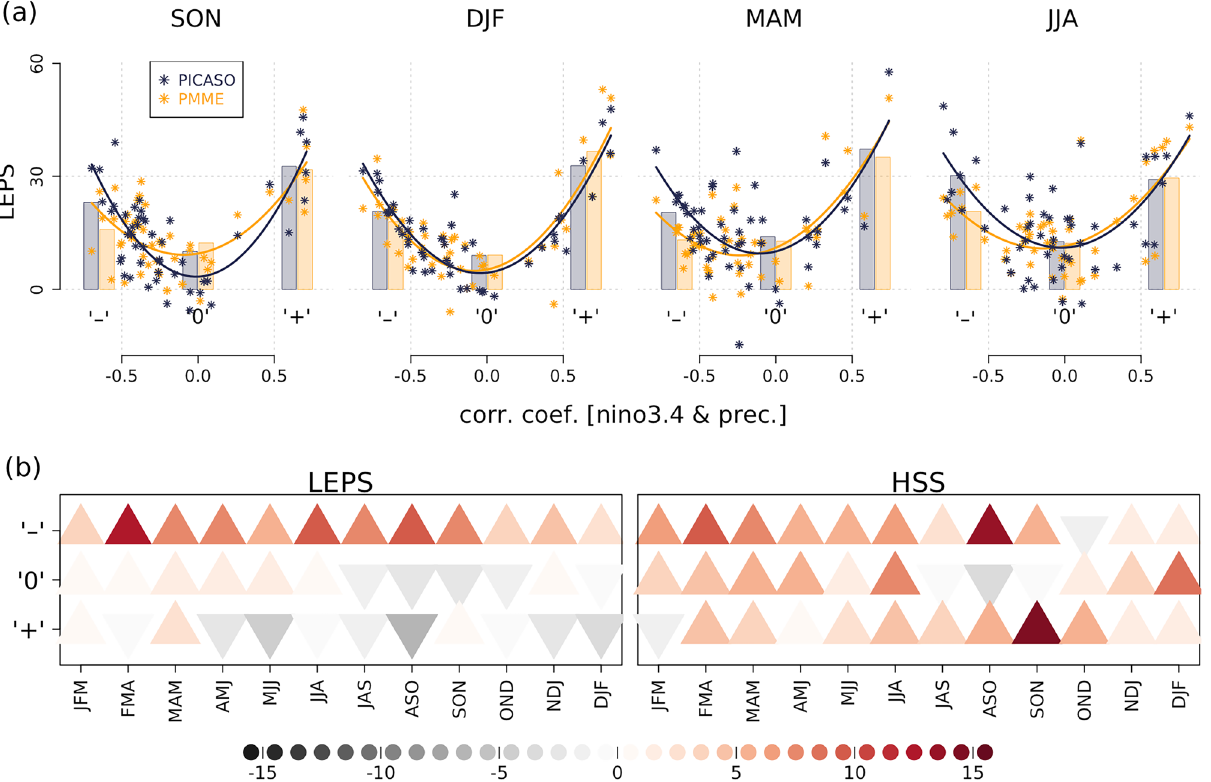
Figure 3. ( a ) Scatter plot of 49 stations between the Niño3.4-precipitation correlation coefficient and LEPS score of (navy) PICASO and (orange) APCC-PMME for four seasons during the training period (1983–2005). The three bars in each panel represent the averaged LEPS of stations for three station categories in terms of their rainfall relationship with ENSO: ‘–’, ‘0’, and ‘+’, respectively. Second-order polynomial line least square fitted to 49 points is delineated for each of the two systems. ( b ) Predictive skill (LEPS and HSS) differences between PICASO and APCC-PMME for three station categories and individual 12 seasons. Reddish upper triangle (grayish lower triangle) indicates the higher (lower) skill of PICASO relative to relationship (‘0’) with ENSO. The classification criteria are correlation coefficients of ± 0.5 between three months rainfall and the Niño3.4 index; for each station, if the correlation coefficient is over + 0.5, it is classified as a ‘+’ category, and if the correlation coefficient is less than − 0.5, then it is classified as a ‘−’ category, and if the cor- relation coefficient is between − 0.5 and + 0.5, then it is classified as ‘0’ category. In APCC-PMME, the LEPS scores for stations with strong ENSO reliance are larger than for stations with no reliance, regardless of season (orange scatters and bars in Fig. 3a). The score is quite high for the positively impacted stations (‘+’) that are located over the southern central Pacific where ENSO-related South Pacific Convergence Zone (SPCZ) variation is dominant (Supplementary Fig. 2). For the negatively related stations (‘–’), the scores for both austral spring and autumn are low. The stations with obscure relationship (‘0’) show the worst PMME scores when heading to austral summer. Notice the asymmetric scores between positively and negatively related stations for PMME: the LEPS score is much lower for the negative ones than that of the positive ones, and is similar to that of the obscure ones during MAM. After tailoring, the LEPS score increases for negatively related stations for all seasons. Thus the 49 stations’ skill distribution becomes more symmetric (navy scatters and bars in Fig. 3a). During JJA, LEPS of negatively related stations is higher than the positive ones, while it is still asymmetric in other seasons. The skill improvement of PICASO is most dominant for the stations where rainfall exhibits a negative relationship to ENSO, but PICASO rarely outperforms PMME for the stations with a positive or obscure relationship with ENSO. Figure 3b displays the skill difference between PICASO and the PMME in terms of ENSO reliance by the sea- sons. As mentioned in Fig. 3, the LEPS score of ‘–’ increases in all 12 seasons, particularly for FMA, JJA, and ASO (Fig. 3b). For ‘0’, the LEPS score marginally increases from JFM to JJA. For ‘+’, the LEPS score tends to decrease in all seasons except for JFM, MAM, and SON. Unlike the LEPS score, HSS shows skill improvement in most cases and the amount of score increase is not very different among the three station categories. For ‘–’, HSS seasonal variation shows a similar tendency to that of the LEPS score, but the maximum increase is found in ASO, not in FMA. For ‘0’, HSS mostly increases, except in three seasons from JAS to SON. For ‘+’, HSS increase is observed in all seasons except JFM, which is very different from the LEPS score. This suggests that performance comparison between the two systems can be different, dependent on which verification metric is utilized. As mentioned in Appendix B, LEPS measures the difference in probabilistic distribution between forecast and observation, while